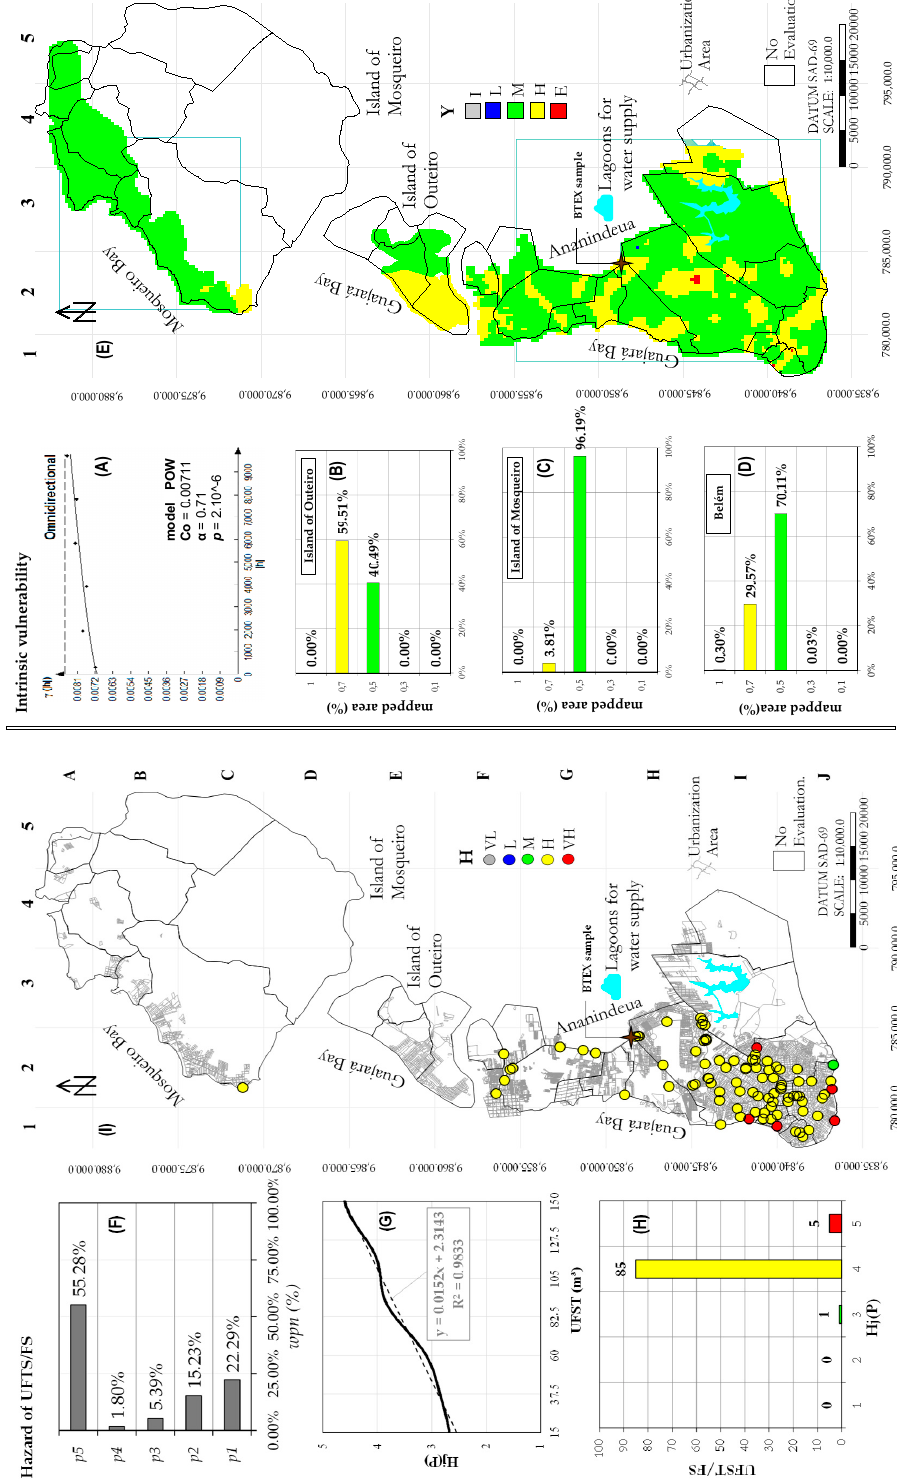
Figure 5. ( A ), ( B ), ( C ), ( D ), ( E ) Intrinsic vulnerability; ( F ), ( G ), ( H ), ( I ) hazard of UFST/FS. Figure 5. ( A – E ) Intrinsic vulnerability; ( F – I ) hazard of UFST /